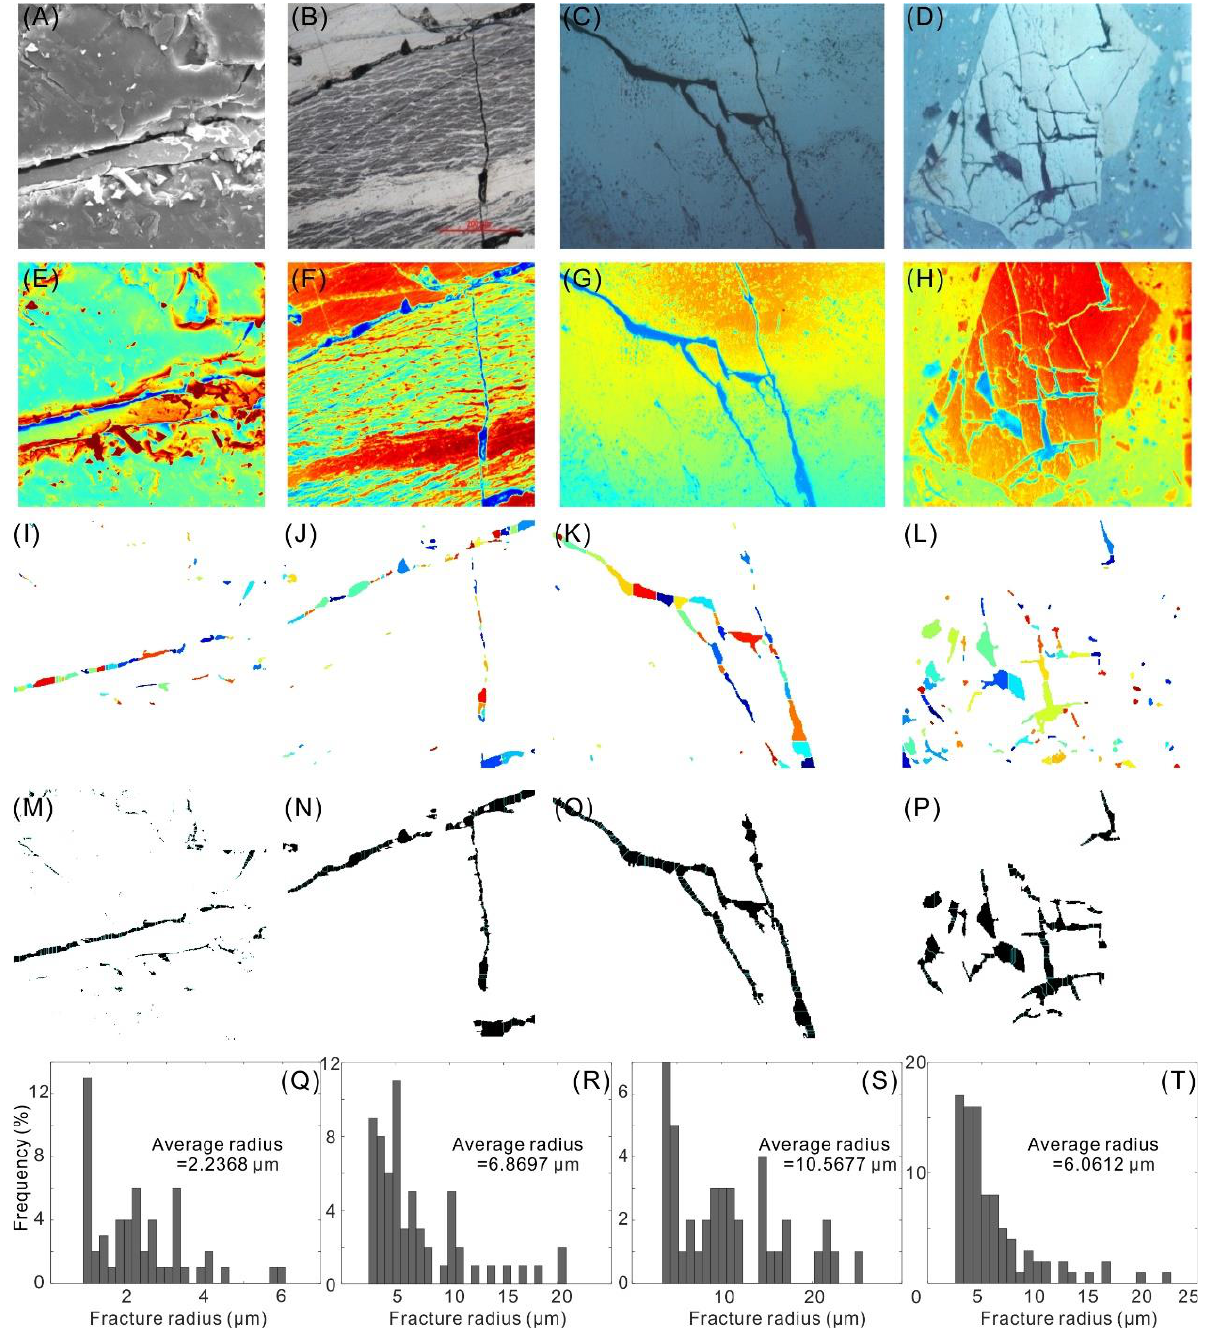
Figure 6. SEM images showing fracture types: ( A ) SX015-5, fracture filled by calcite; ( B ) WZ03, micro-fractures; ( C ) SX306-23, tensional fracture; ( D ) SX008-2, shear fracture. ( E – H ) Adaptive threshold images of ( A – D ); ( I – L ) pore unit segmentation images of ( A – D ); ( M – P ) pore radius identification of ( I – L ); ( Q – T ) pore radius distribution of ( A – D ).